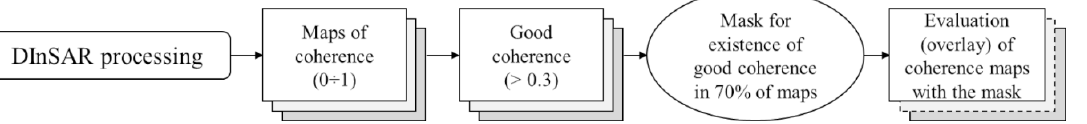
Figure 3. Procedure for evaluation of the quality of DInSAR displacement maps. Remote Sens. 2019 , 11 , x FOR PEER REVIEW